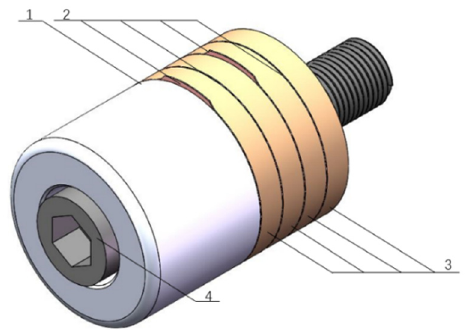
Figure 1. Structure diagram of the PZT transducer. 1. Back block; 2. electrodes; 3. PZT ceramics; 4. connect bolt.